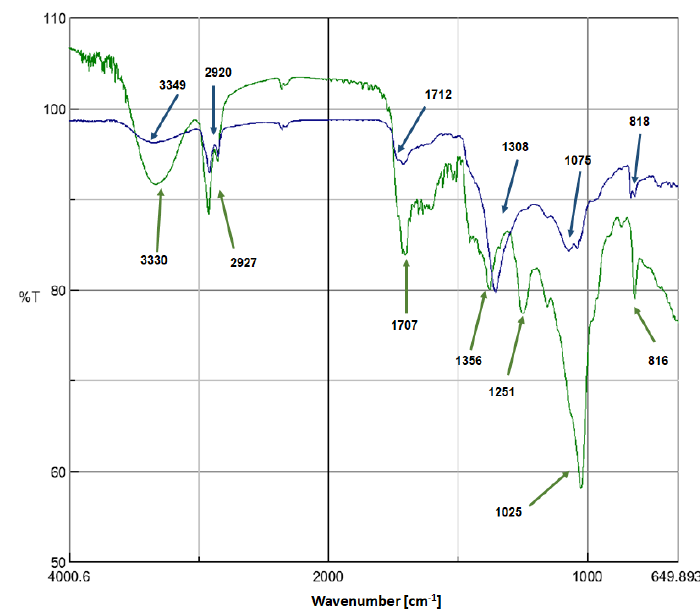
Figure 3. FTIR spectra of the OSM leaf extract (green) and OSM-AgNPs (blue).